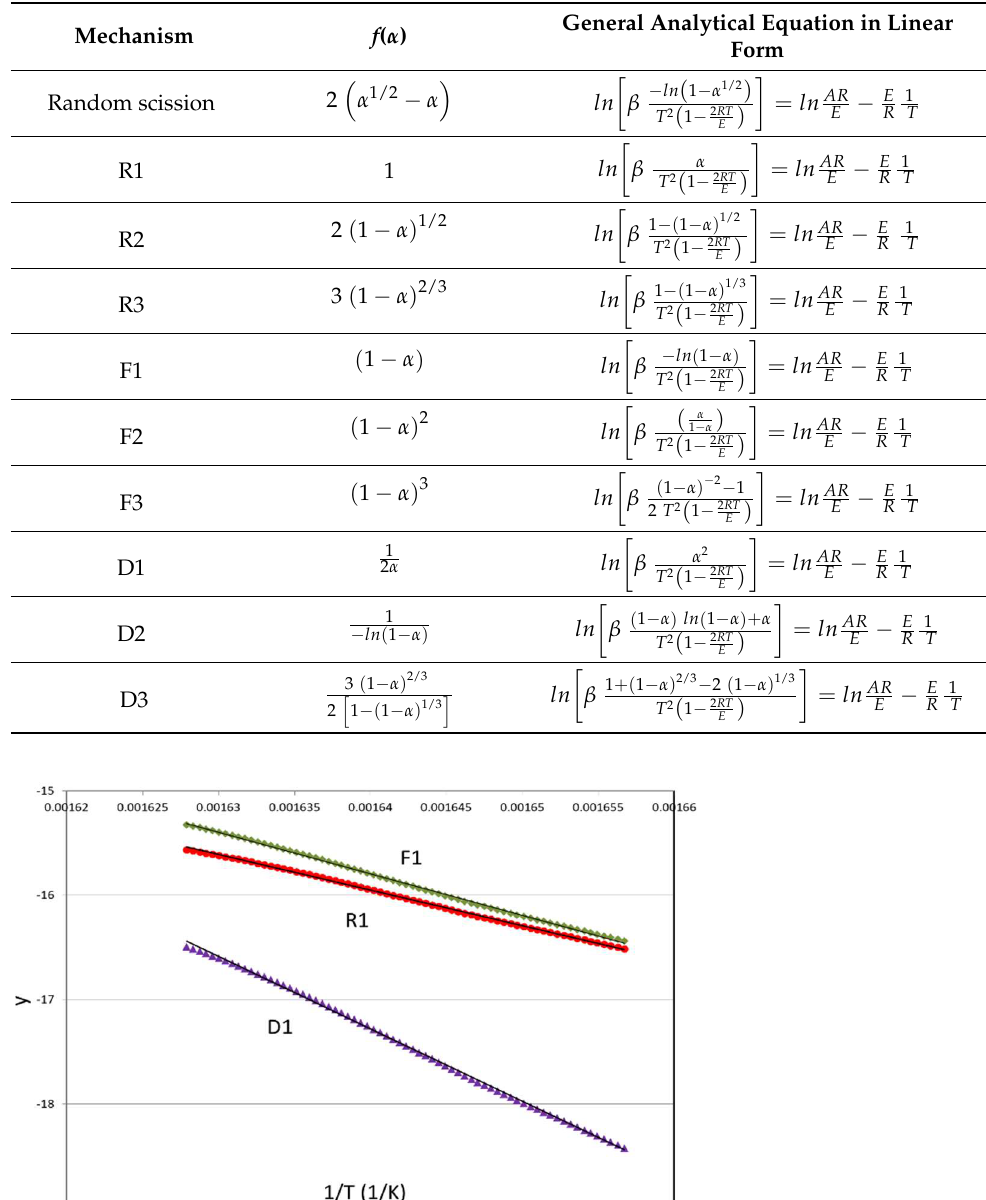
Table 3. Kinetic equations in linear form for the solid-state mechanisms used in this study. Mechanism f ( α ) Random scission